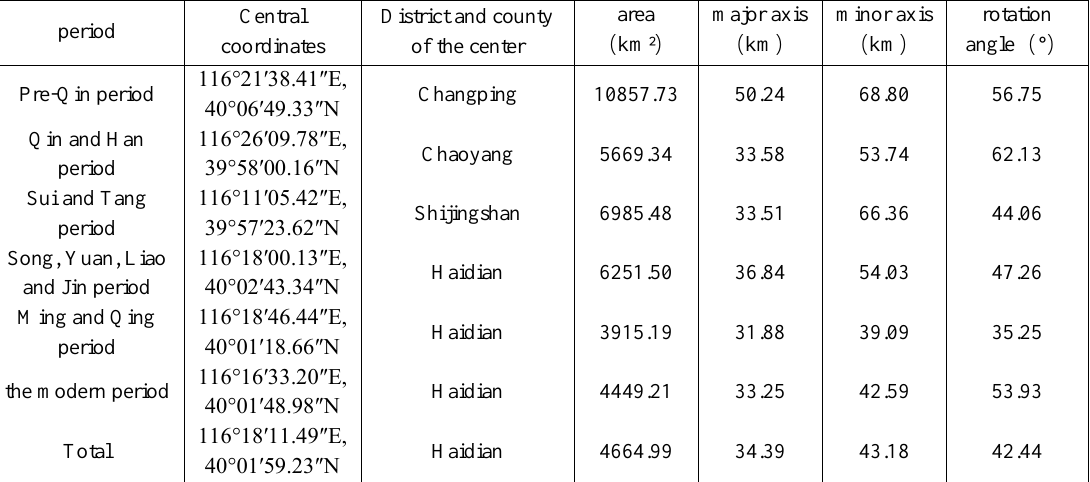
Table 2. Standard deviation ellipse analysis of Beijing's cultural preservation units.